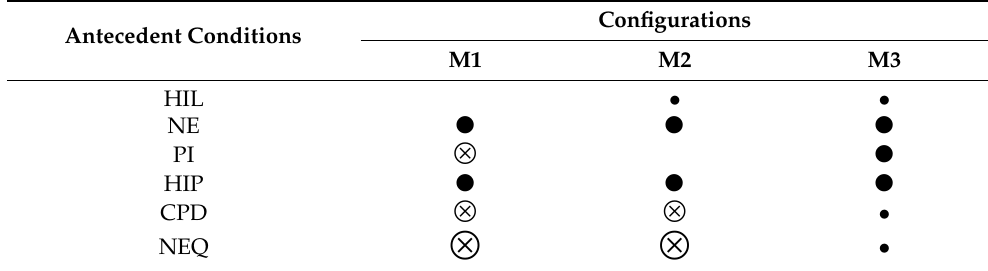
Table 3. Health-information-avoidance behavior pathways.